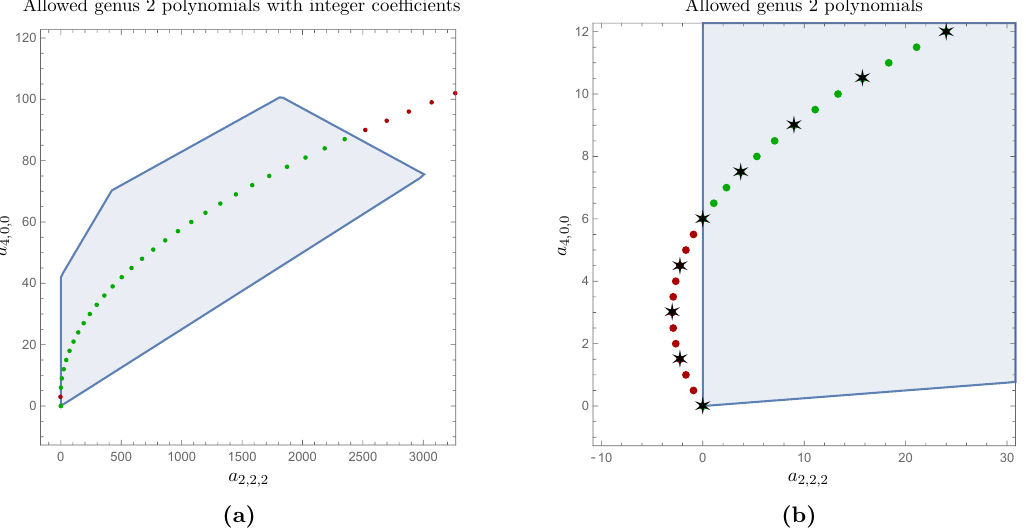
Figure 3. Allowed polytope for the genus 2 coefficients. Green dots represent polynomials which lie inside the bounds, and red outside. Plot (a) shows all 29 allowed genus 2 polynomials with integer coefficients. In (b), we zoomed into the bottom left, and allowed for half-integer coefficients in P 1 allowing a larger number of solutions. Black stars represent lattices. We can see the k = 4 , inv k = 5 , and k = 6 lattices outside the allowed